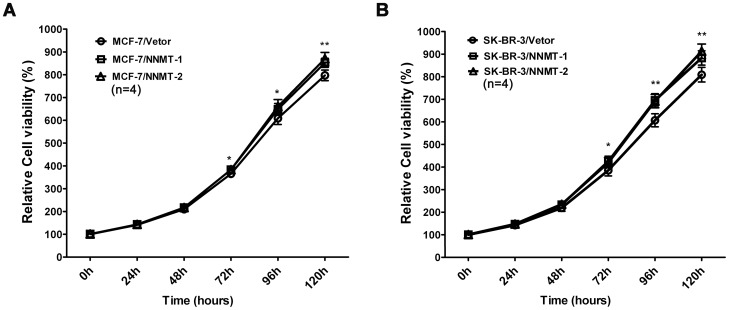
Overexpression of NNMT increased the plate efficiency and enhanced the capacity of colony formation in soft ager.(A, B) To test plate colony formation of MCF-7 and SK-BR-3 cells transfected with pcDNA3.1/NNMT, cells were placed in wells with media and incubated for 14 days before counting the number of colonies (foci>50 µm). The plate efficiency of MCF-7/NNMT-1 and MCF-7/NNMT-2 cells was higher than that of MCF-7/Vector group. The similar result was found in SK-BR-3 cell models (B). (C, D) The colony formation numbers of MCF-7/NNMT-1 and MCF-7/NNMT-2 cells foci >100 µm after 14 days were more numerous than that of MCF-7/Vector group (*P<0.05). The similar result was found in SK-BR-3 cell models (D). Values are expressed as means ± SD of four independent experiments.